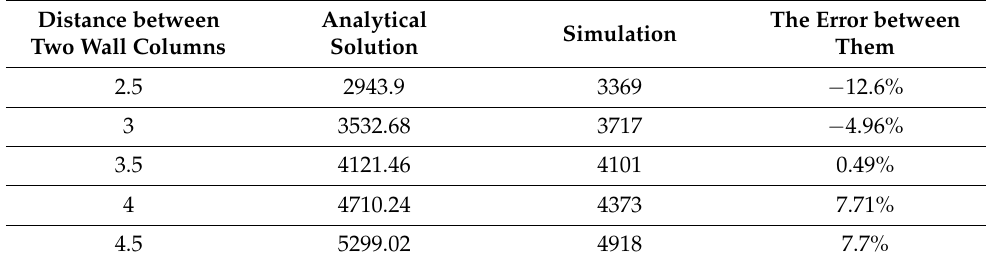
Table 3. The comparison between simulation and analytical solution with different distances between two wall columns.